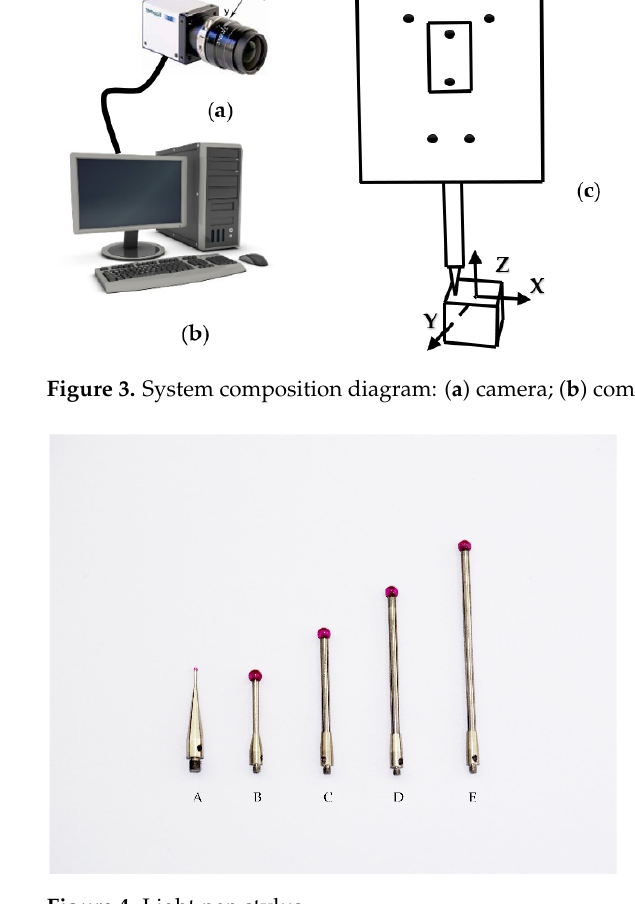
Figure 4. Light pen stylus. Figure 4. Light pen